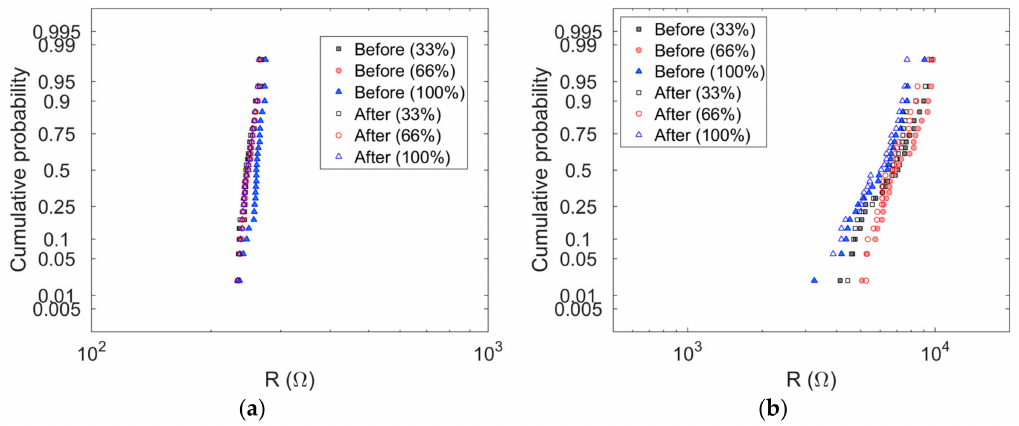
Figure 5. Cumulative distributions of the resistance values for a RRAM (15 × 15 µ m 2 ) before and after a single laser pulse (spot size of 25 µ m)., sweeping the power source value ( a ) RRAM in the LRS ( b ) RRAM in the